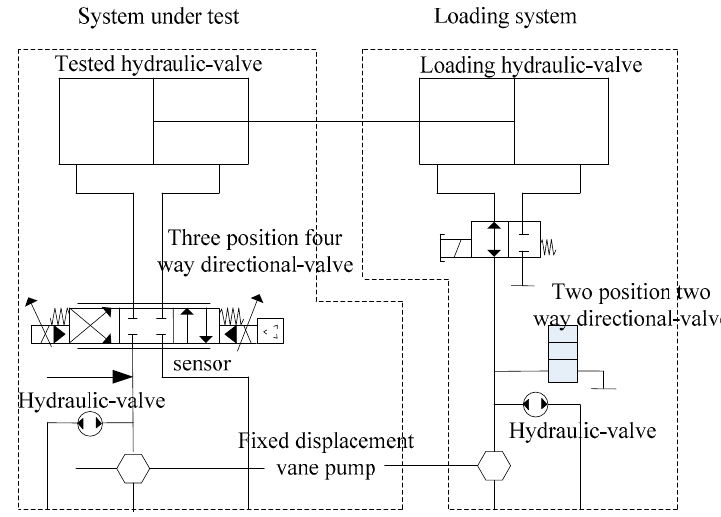
Figure 5. Schematic diagram of the experiment.